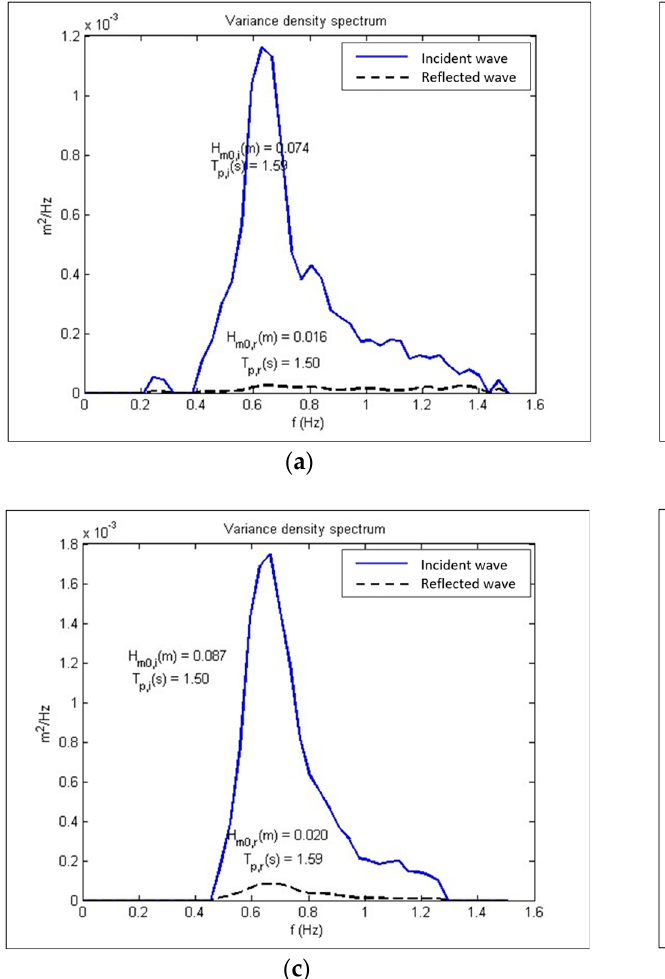
Figure 14. Variance spectrum of the reflected wave in different water depths. ( a ) TH6-d26H10T15, Depth d = 26 cm, Variance density spectrum; ( b ) TH6-d33H10T15, Depth d = 33 cm, Variance density spectrum; ( c ) TH6-d40H10T15, Depth d = 40 cm, Variance density spectrum; ( d ) TH6-d47H10T15, Depth d = 47 cm, Variance density spectrum.